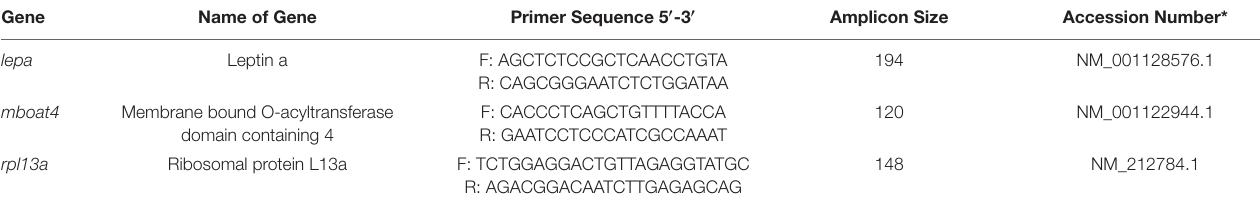
TABLE 1 | List of Primer sequences used in Quantitative Realtime PCR (RT-PCR) analysis.